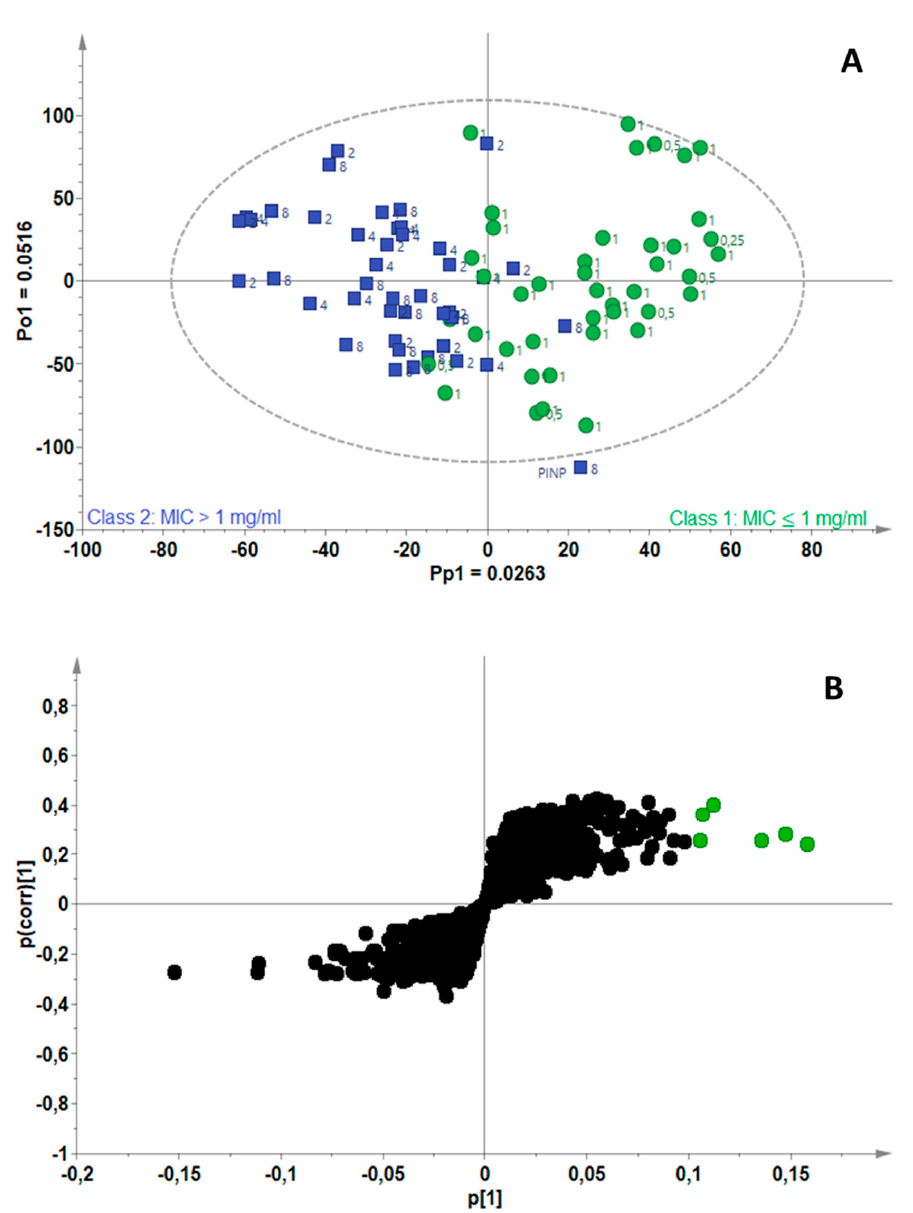
Figure 4. ( A ) OPLS-DA scores scatterplot for Mycobacterium gordonae , showing separation of active (green) and non-active (blue) essential oils, ( B ) S-plot of the variables, indicating the putative biomarkers (green) associated with essential oils active against M. gordonae.